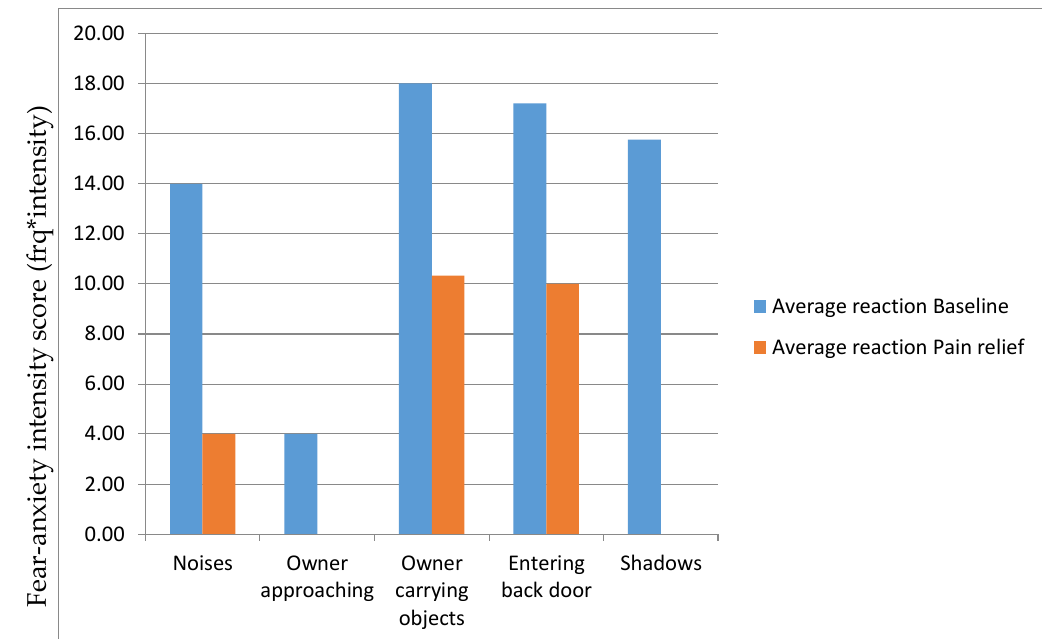
Figure 1. Intensity of fear/anxiety in five contexts for a patient scored before and after receiving analgesia. Frequency score: never = 0, rarely = 1, frequently = 2, every time = 3; intensity score: 1 = small amount − 5 = extensive amount.